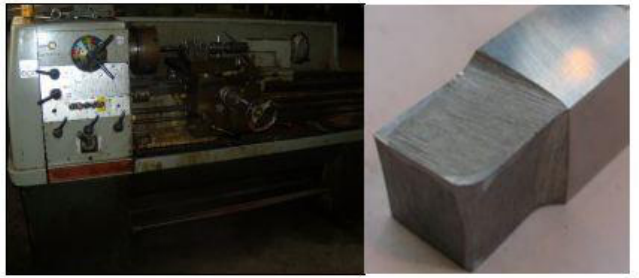
Figure 1: Colchester Lathe machine and HSS tool